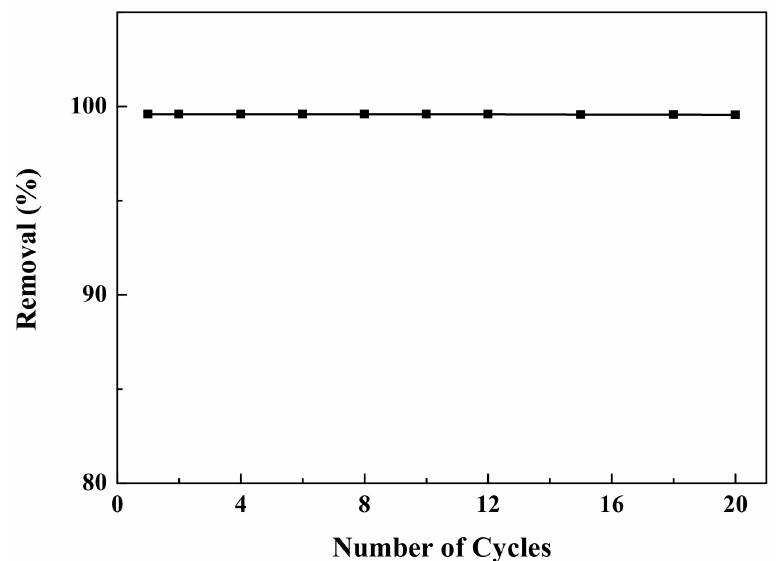
Figure 12. Effect of number of cycles on the removal efficiency of reactive brilliant yellow R-4GLN solution over carbon-supported metal